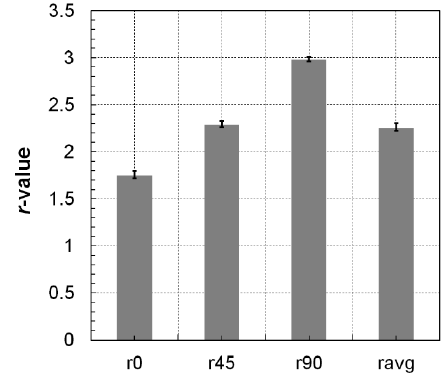
Figure 8. Dependence of the plastic anisotropy parameters on specimen orientation at room